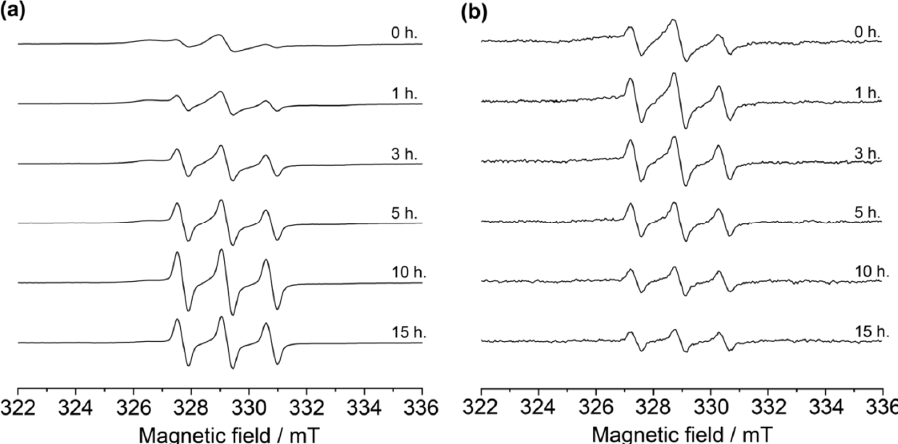
Figure 3. EPR spectra of A549 cells after their 1 h incubation with ( a ) 5.5 μ M and ( b ) 0.5 μ M sRL2 (molar ratio of spin label 1 to RL2 2 : 4) acquired at different time points after the incubation. The zero time point corresponds to the start of EPR spectra acquisition. Initial spin concentrations observed by EPR at the zero time point for these two samples were 730 μ M ( a ) and 60 μ M ( b ). The spectra were acquired at 35 °C with the following parameters: microwave frequency ( a ) 9.236816 GHz, ( b ) 9.233912 GHz; ( a , b ) microwave power 2.0 mW; conversion time ( a ) 30.89 ms, ( b ) 19.54 ms; sweep time ( a ) 15.82 s, ( b ) 10.00 s; time constant ( a ) 40.96 ms, ( b ) 20.48 ms; ( a , b ) 512 points; the number of scans ( a ) 16 or ( b ) 64. In both cases, the external magnetic field was modulated at frequency 100 kHz and modulation amplitude 0.2 mT.